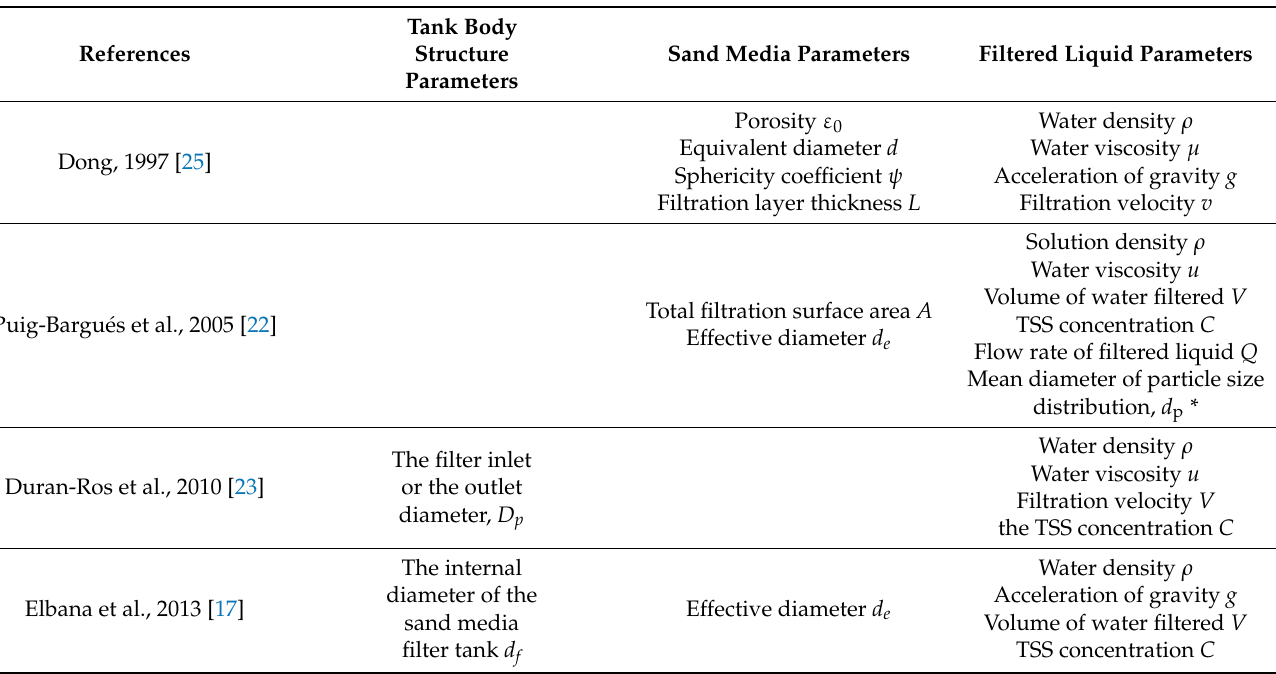
Table 3. Related technical parameters in previous